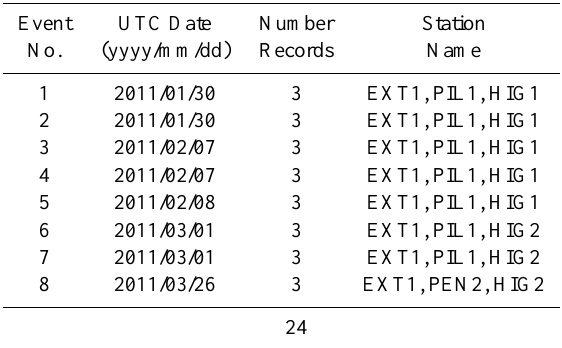
Table 1a. Events analyzed in this study: Peñamiller Earthquake Se- quence (PES).